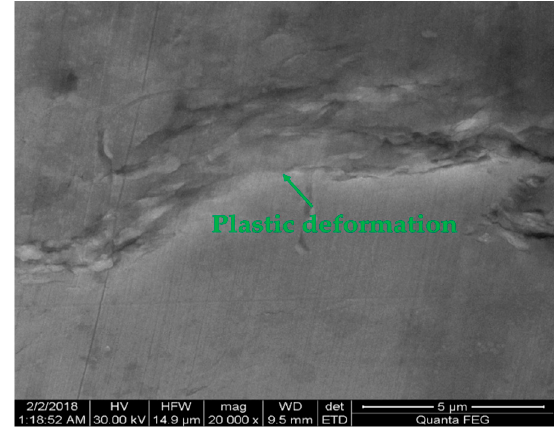
Figure 9. Morphology of the specimen’s surface away from crack initiation zone.